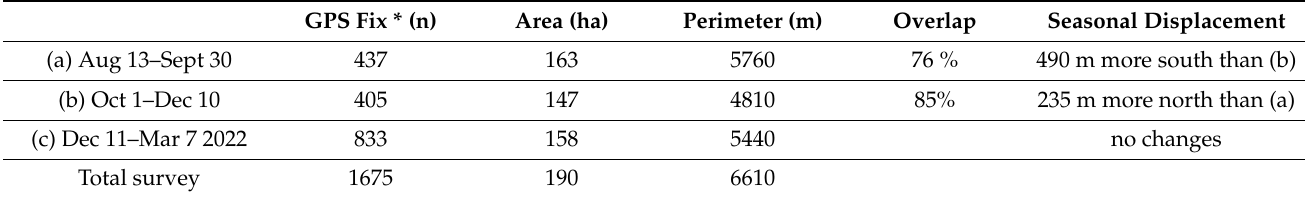
Table A2. Scale of the spatial behavior of Male 3 (satellite radio collar) at the end of winter, and the autumn of